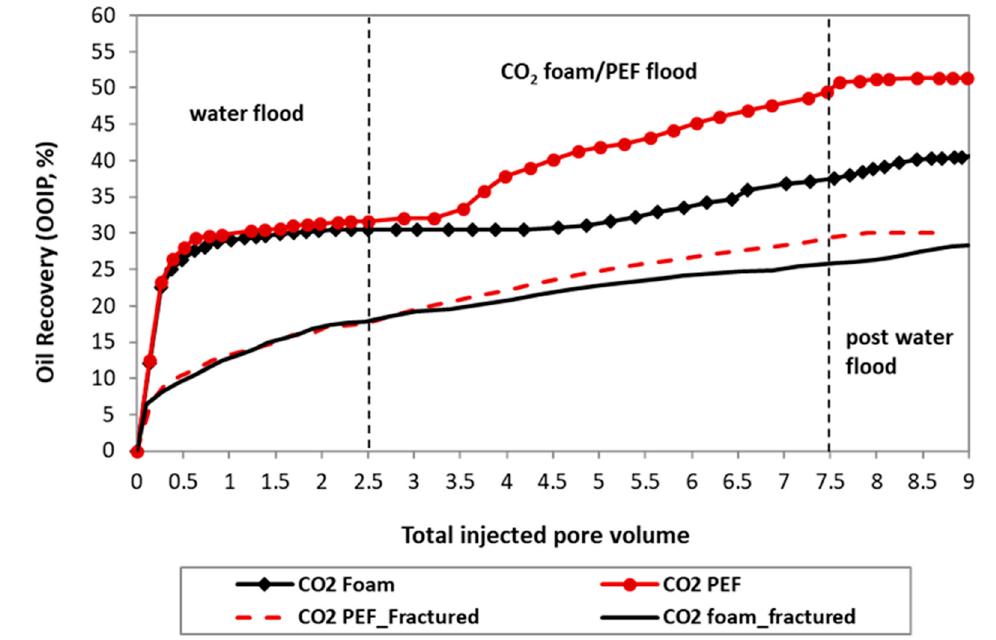
Figure 10. Oil recovery profile during waterflood, CO 2 foam/PEF flood in homogenous, and fractured rock samples. The dashed line marks the start of each fluid injection.